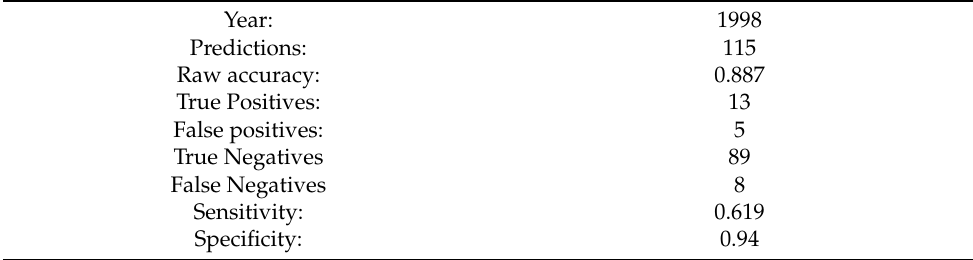
Table 5. Multilayer perceptron metrics for the target